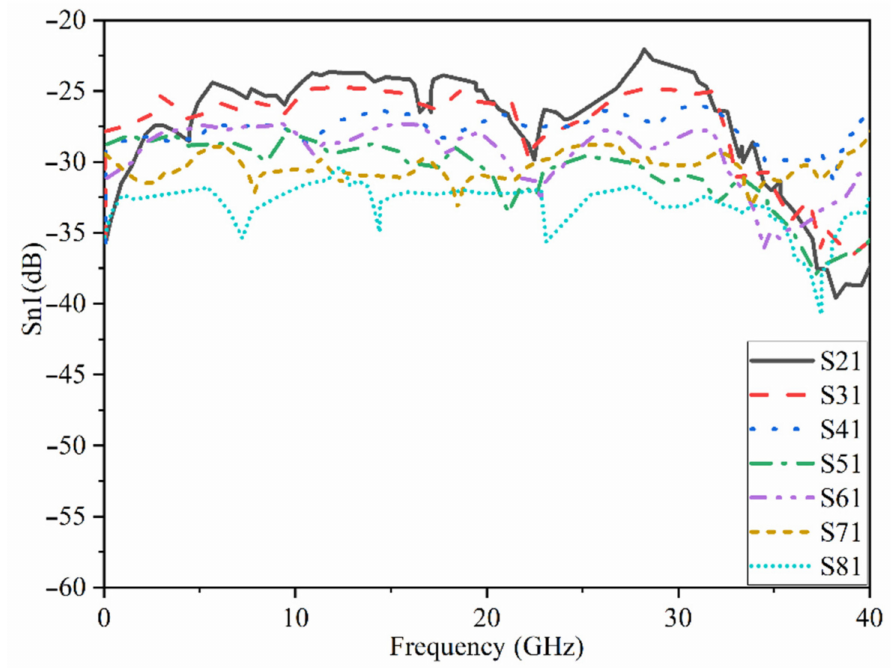
Figure 21. Measured transmission coefficients of the UWB-MIMO